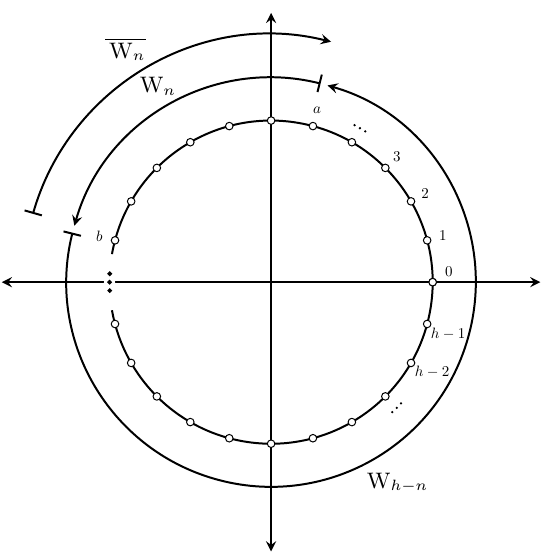
Figure 1 . Vacua of 4 d N = 1 SYM realized as the h roots of unity in the h tr λλ i -plane, where Z acts by a 2 π/h rotation. W 2 h by n steps counterclockwise, and W orientation reversed. Clearly, W